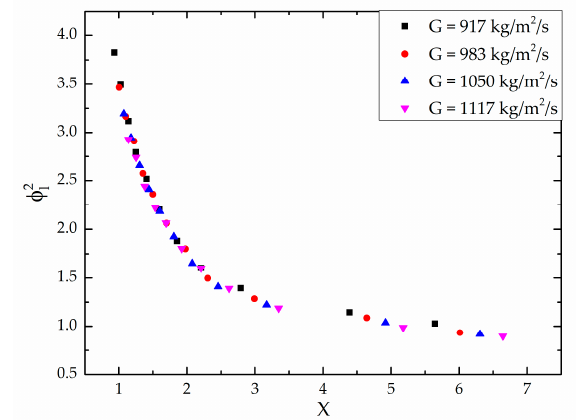
Figure 5. Variation of the two-phase frictional multiplier ( 𝜙 (cid:3039)(cid:2870) ) with respect to the vapor quality un- der different mass velocities.